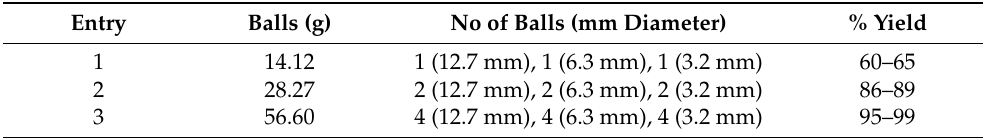
Table 1. Milling of 100 mg of 3,3 (cid:48) ,4,4 (cid:48) -biphenyltetracarboxylic anhydride and 174 mg of octyl aniline at 20 Hz for 15 min.